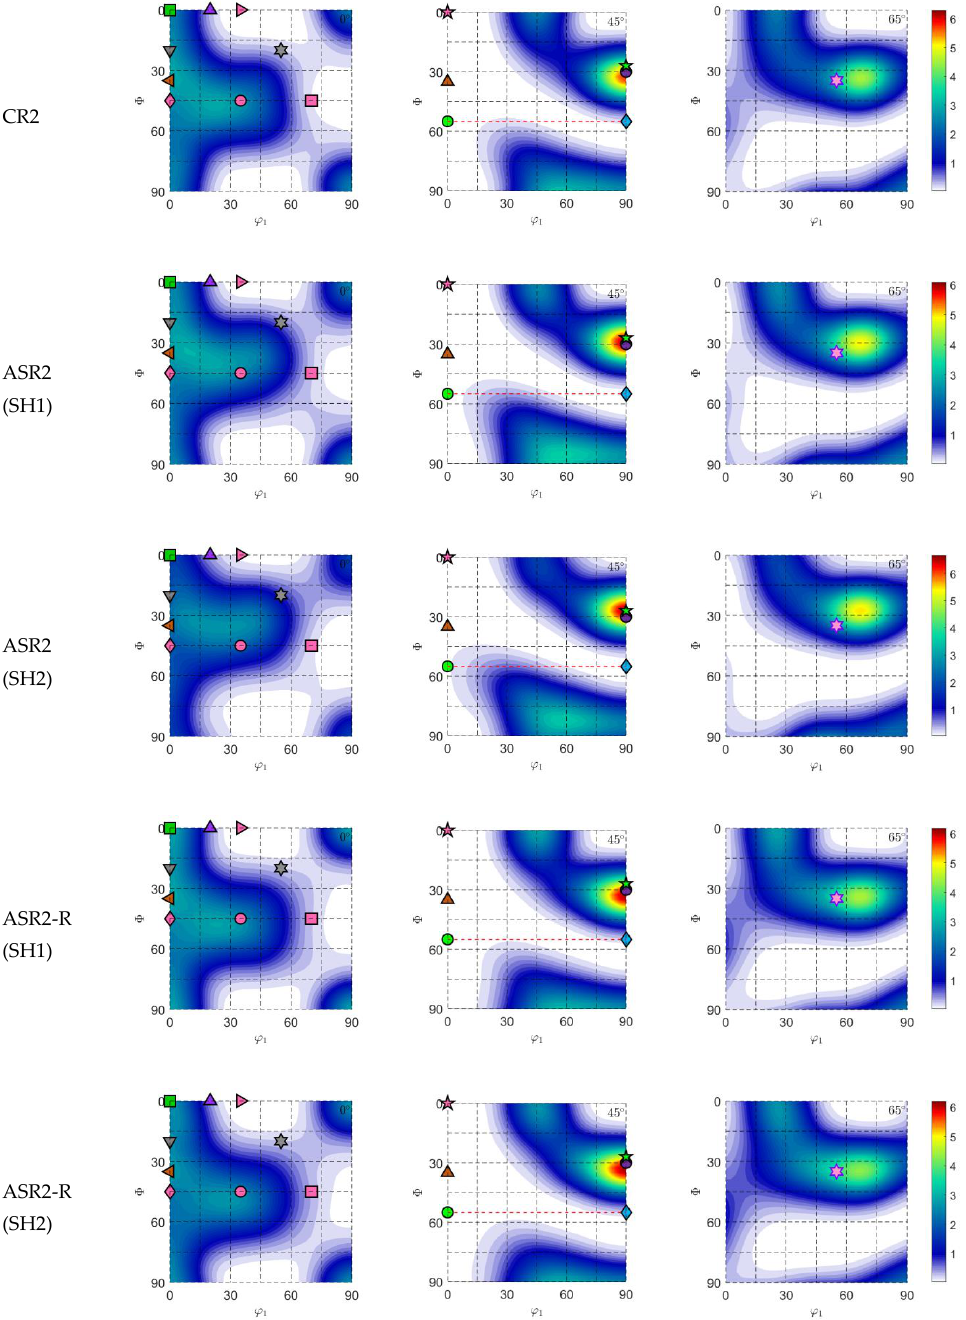
Figure A11. ODF sections for the second pass with a 30% thickness reduction per